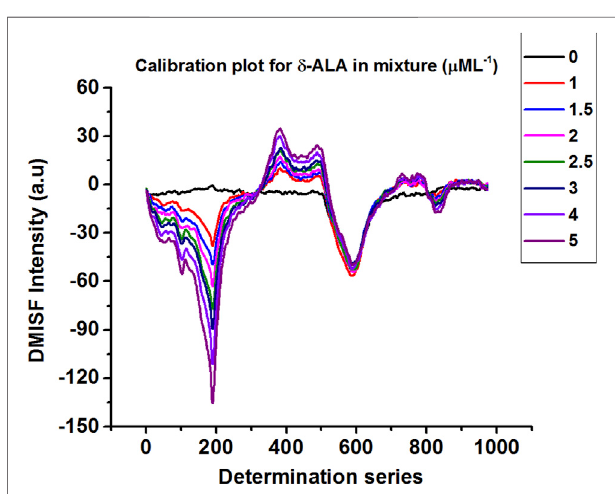
FIGURE5| DMISFspectraof8 μ molL − 1 PBGwithincreasingamountof δ -ALA 0 – 5 μ mol L − 1 .